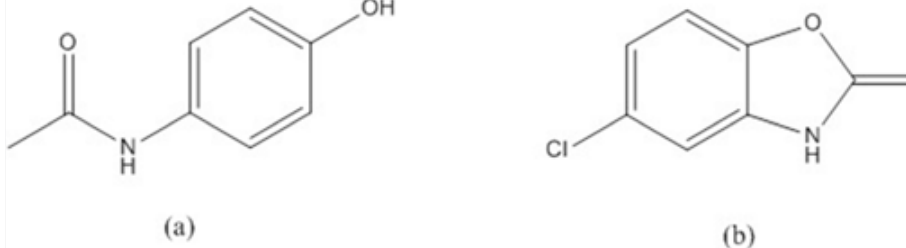
FIGURE 1 - Chemical structure of (a) paracetamol, (b) chlorzoxazone.